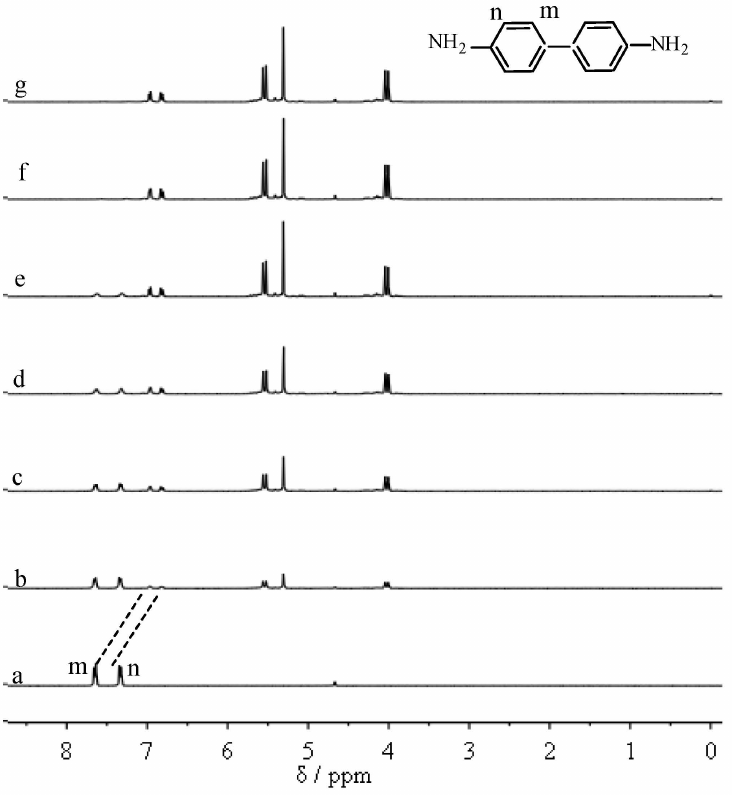
Figure 2. The 1 H NMR (400 MHz) titration of NA with Q[7] in D 2 O (a 1:0.1; b 1:0.2; c 1:0.4; d 1:0.6; e 1:0.8; f 1:1; g 1:1.2).